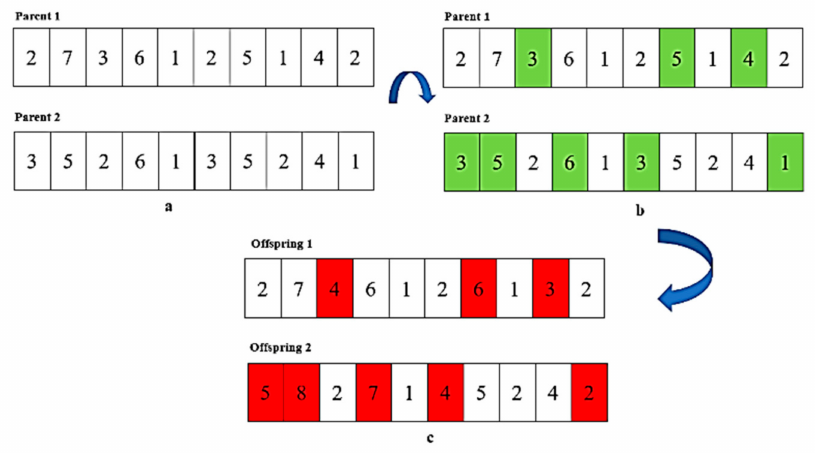
Figure 8. Random Mutation with a pre-defined mutation